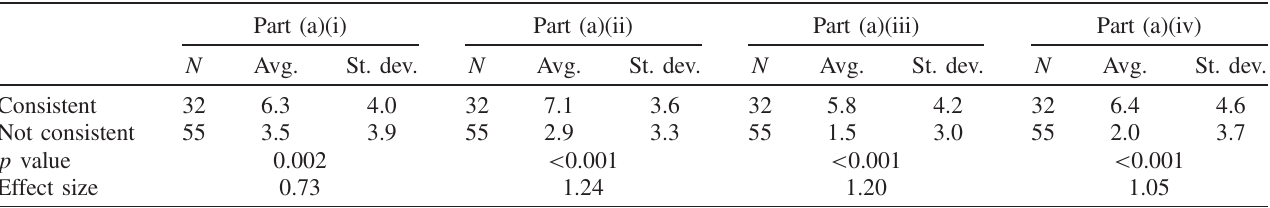
TABLE VI. Numbers of students ( N ), averages (Avg.), and standard deviations (St. dev.) in each part in which the scores were based on expressions for students who were consistent in all parts ( “ Consistent ” ) and for students who were not consistent in one or more parts ( “ Not consistent ” ), and p values and effect sizes for comparison between these two groups of